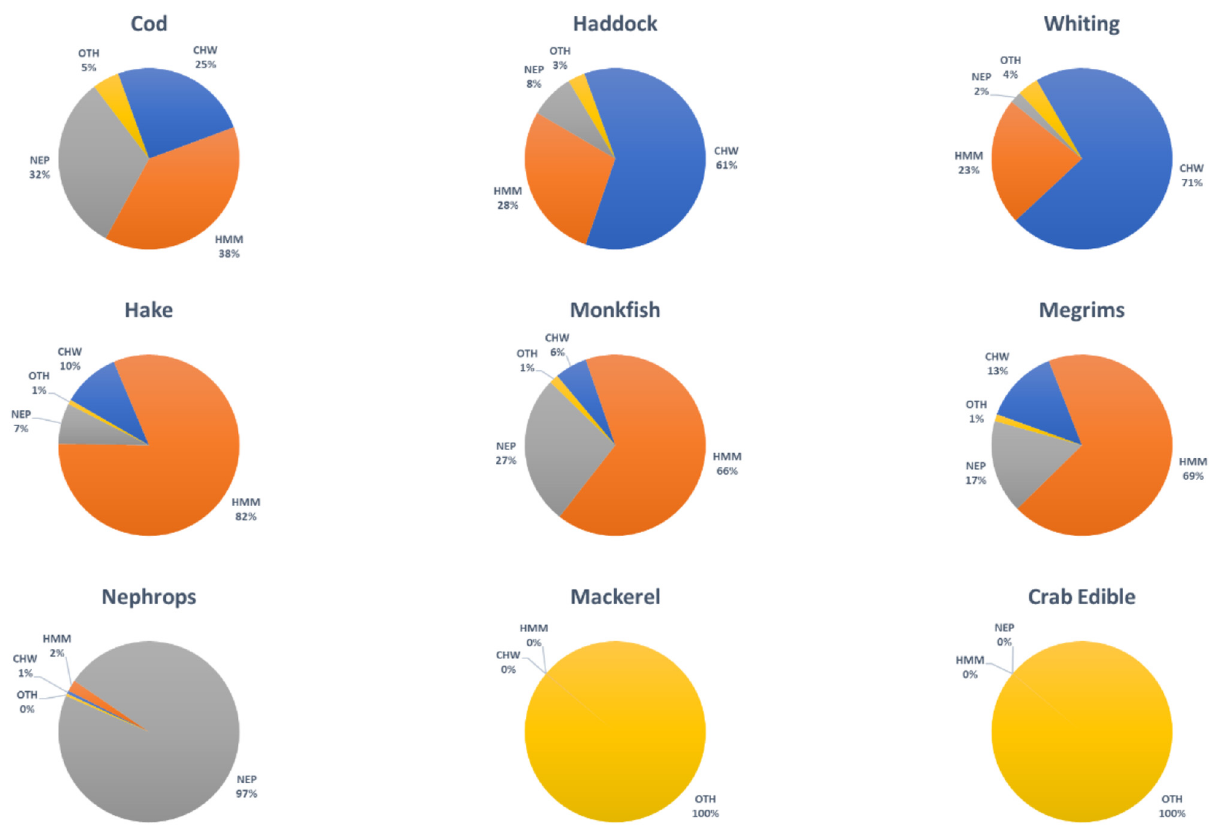
Fig. 4. Landing weights as a fraction of total tonnage landed of main species within each fi shery (cod, haddock, whiting (cid:2) CHW; hake, monk fi sh, megrim (cid:2) HMM; nephrops (cid:2) NEP; all others (cid:2) OTH) in